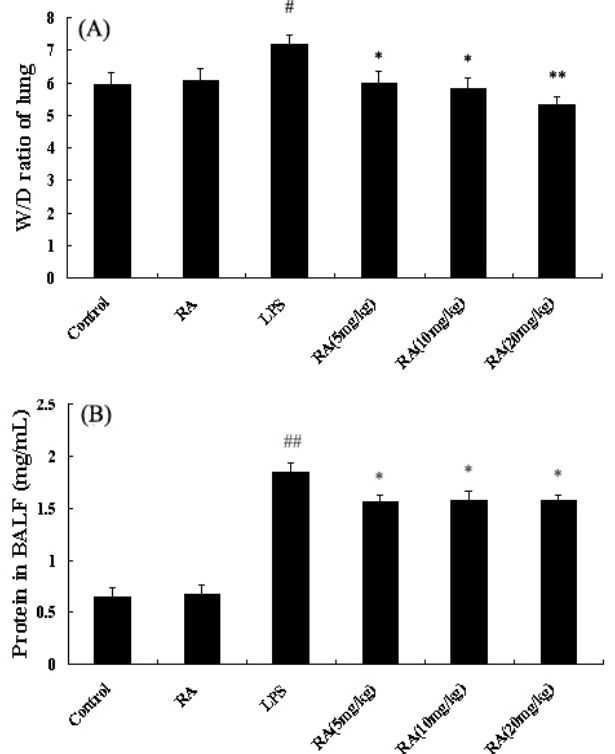
Figure 3. Effects of RA on the lung W/D ratio and total protein level in the BALF of LPS-induced ALI mice. Mice were given RA (5 mg/kg, 10 mg/kg, and 20 mg/kg) 1 h prior to an i.n. administration of LPS. The lung W/D ratio ( A ) and total protein concentration in the BALF ( B ) were determined 24 h after the LPS